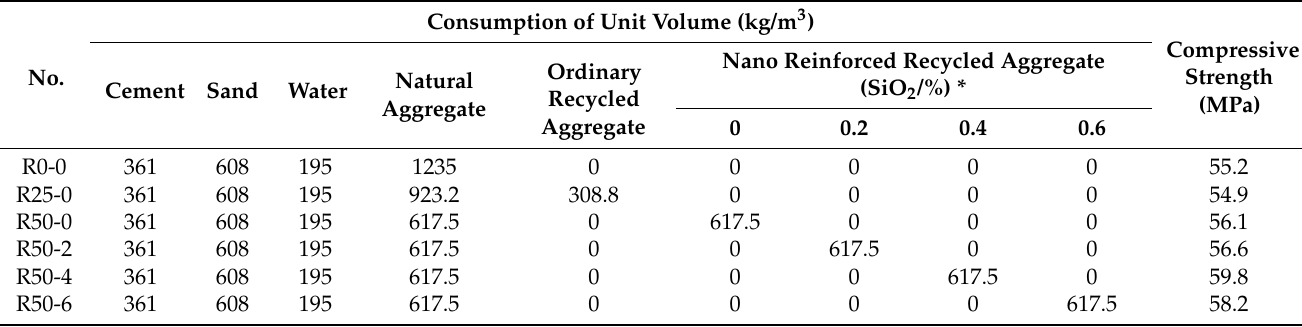
Table 4. Mix proportion and compressive strength of recycled aggregate